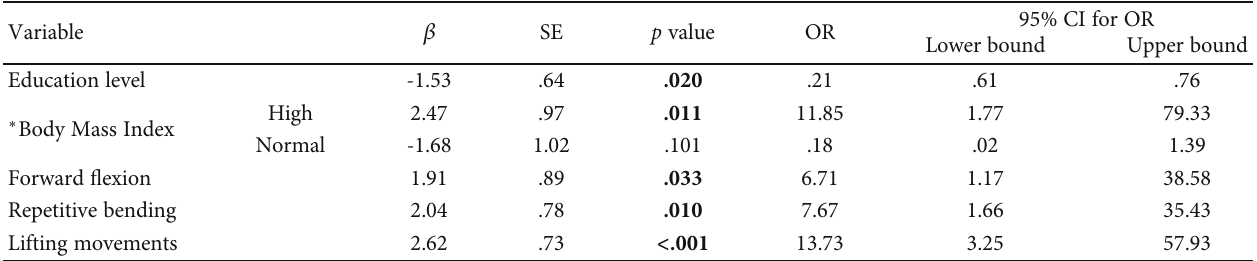
Table 2: Comparison of multiple logistic regression